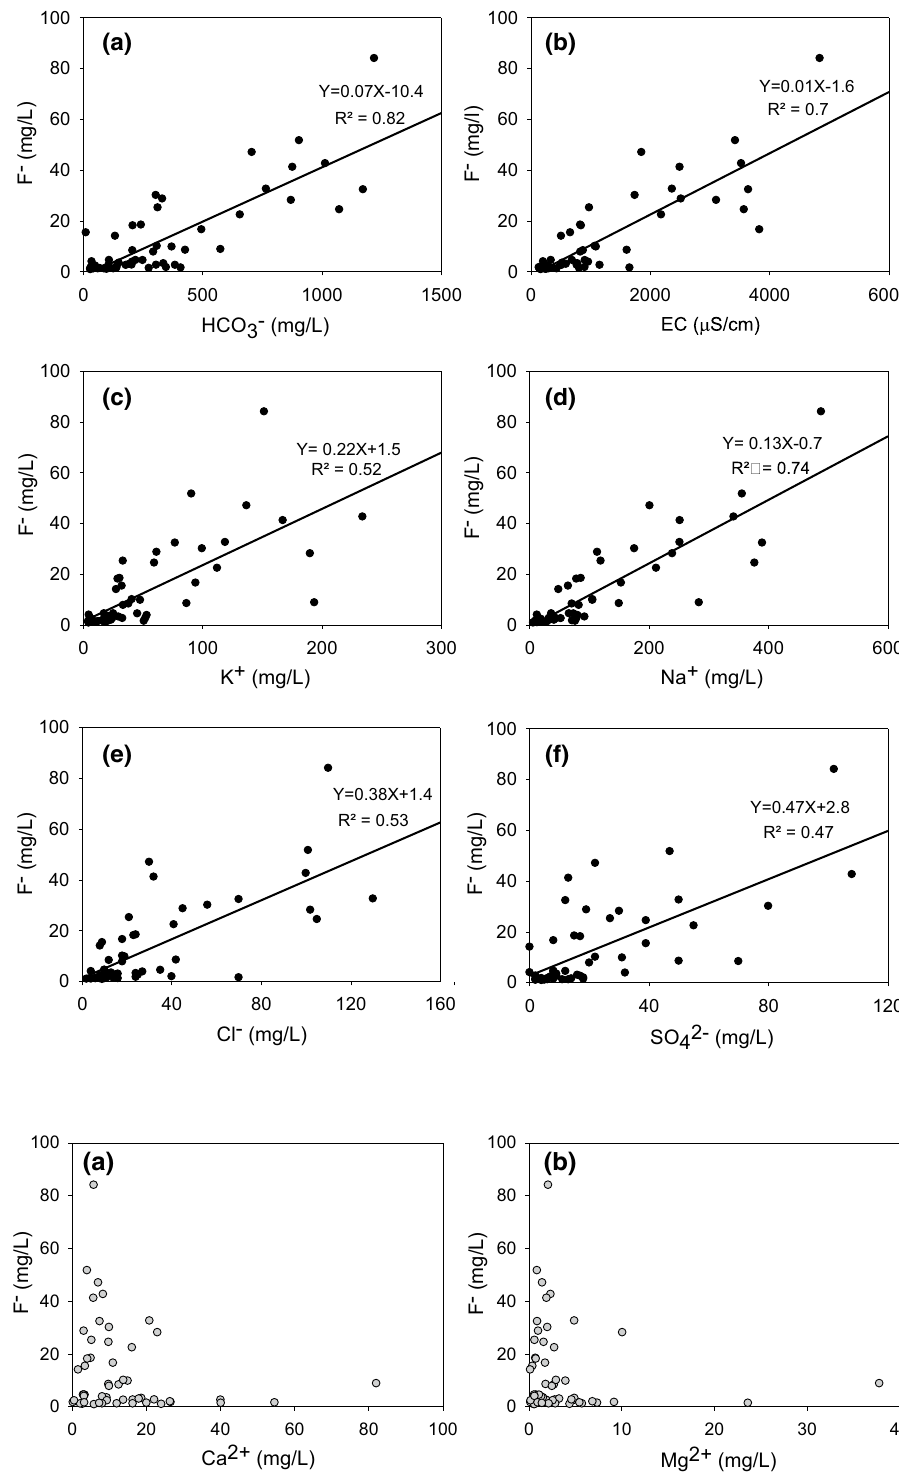
Fig. 12 Relationship between Fluoride and Ca 2+ , Mg 2+ in Meru water